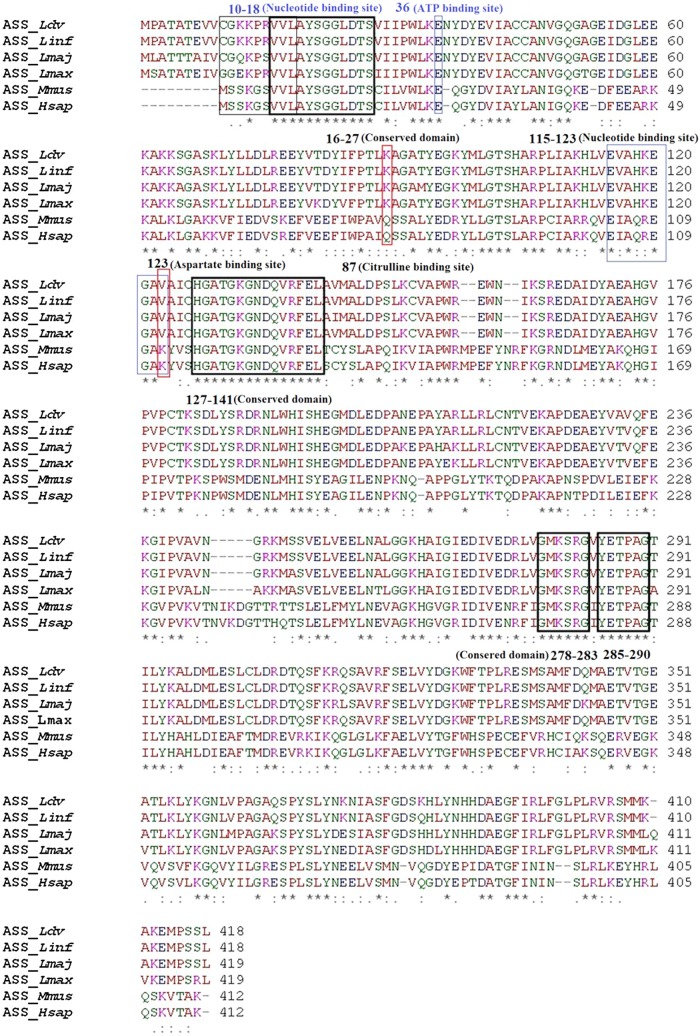
Sequence alignment of the L. donovani, L. infantum, L. major, L. mexicana, mouse and human argininosuccinate synthase.The predicted amino acid sequence of LdASS was aligned with other Leishmania sp.ASS as well as with ASS of mice and human using Clustal W software (version 2.0). The nucleotide binding domain, some conserved domain, ATP binding domain, aspartate binding domain, citrulline binding domain are shown in box.